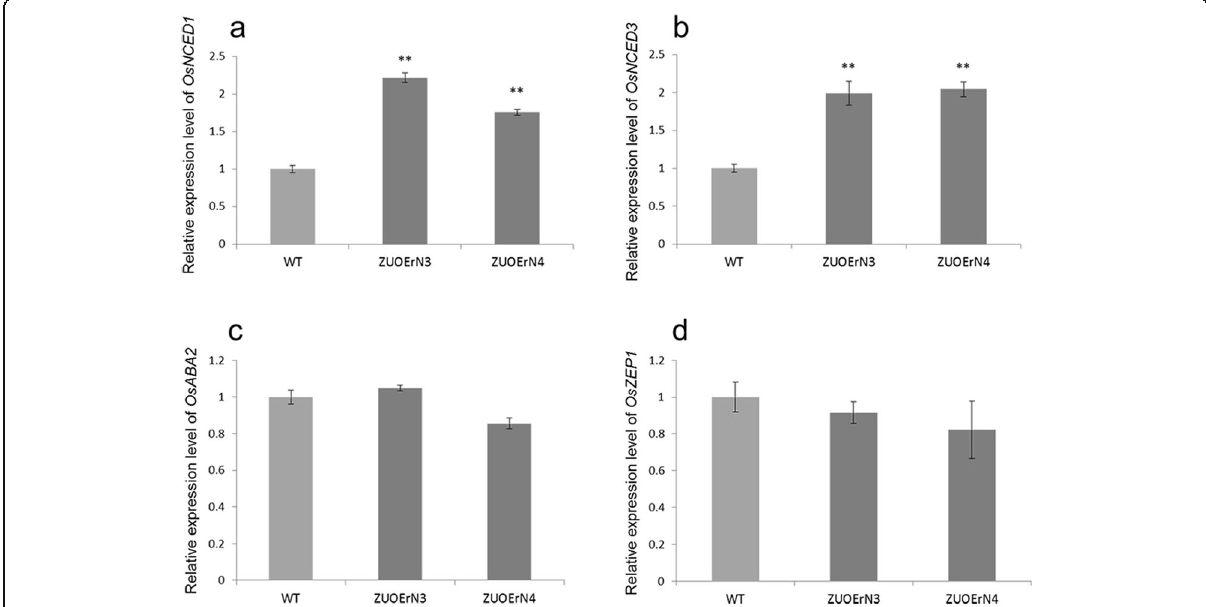
Fig. 5 Expression levels of ABA biosynthesis-related genes. The relative expression levels of OsNCED1 ( a ), OsNCED3 ( b ), OsABA2 ( c ), and OsZEP1 ( d ) were assessed using RT-qPCR with leaves at the tillering stage. The data were normalized using the rice UBI gene and are shown relative to WT. Error bars represent SD of three biological replicates. ** P < 0.01 ( t